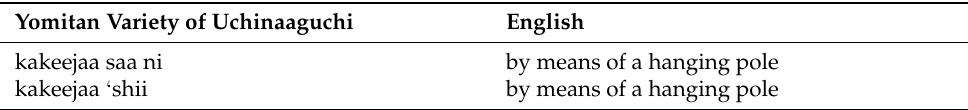
Table 13. Postpositional particles from the